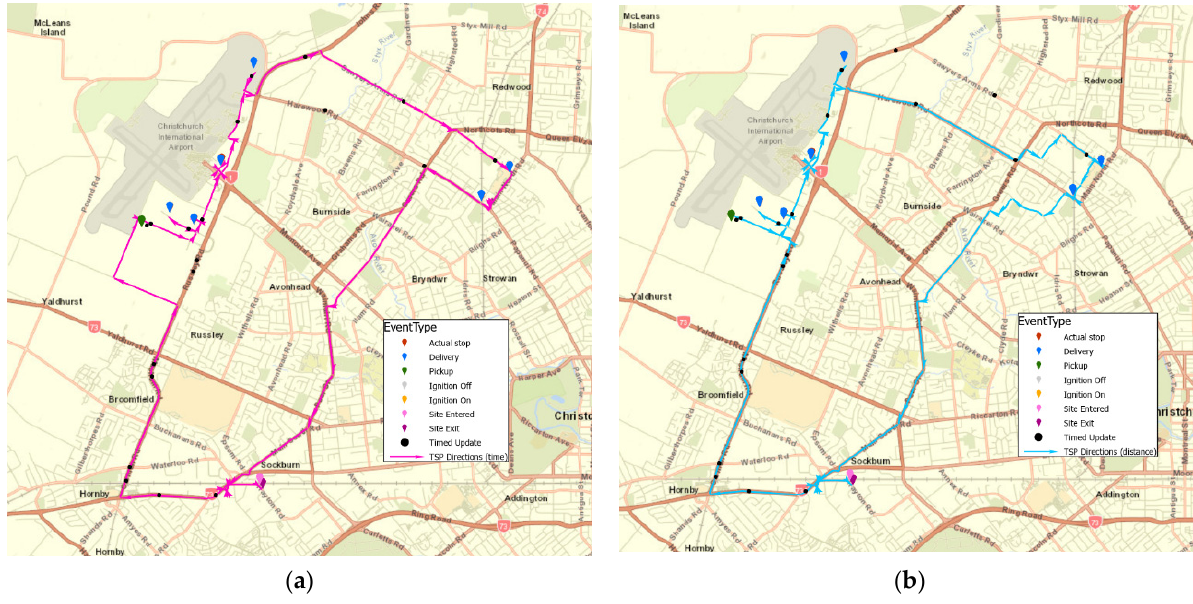
Figure 11. ( a ) TSP route by time measurement; ( b ) TSP route by distance measurement.